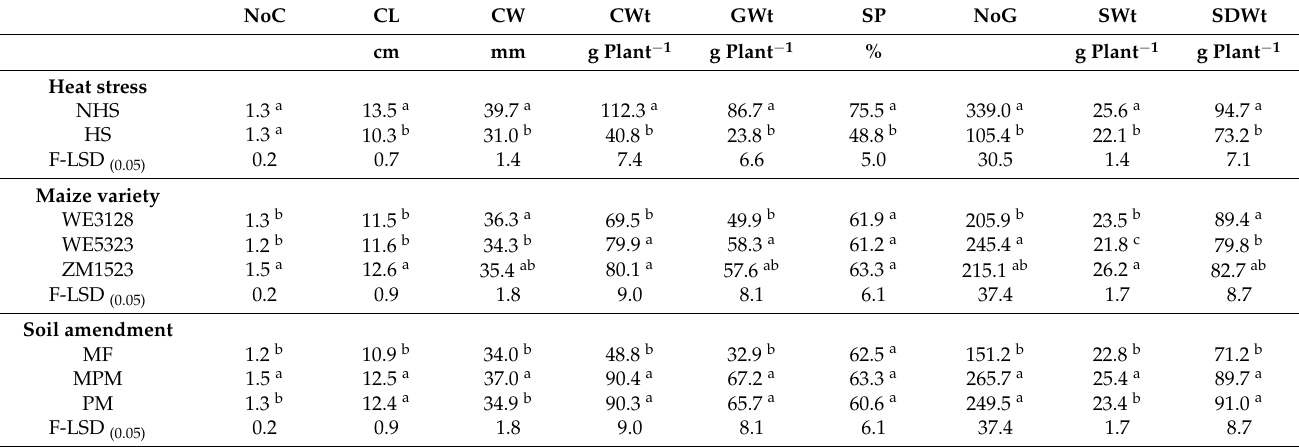
Table 1. Main effects of heat stress, maize variety, soil amendment, and soil type on the maize yield